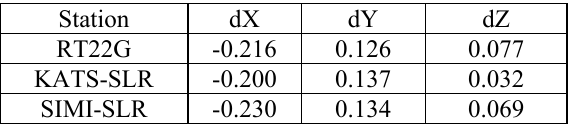
Table 2. Offsets for 10 years of the coordinates of points in the Simeiz-Katsively area.